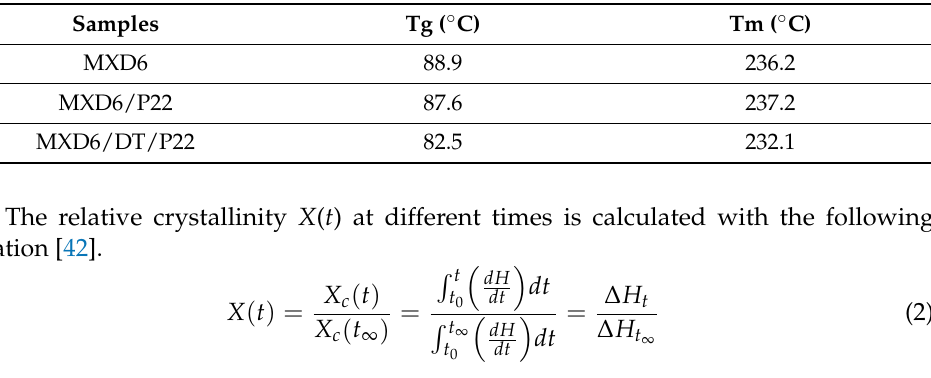
Table 3. DSC results of the 2nd heating process of neat and modified MXD6.